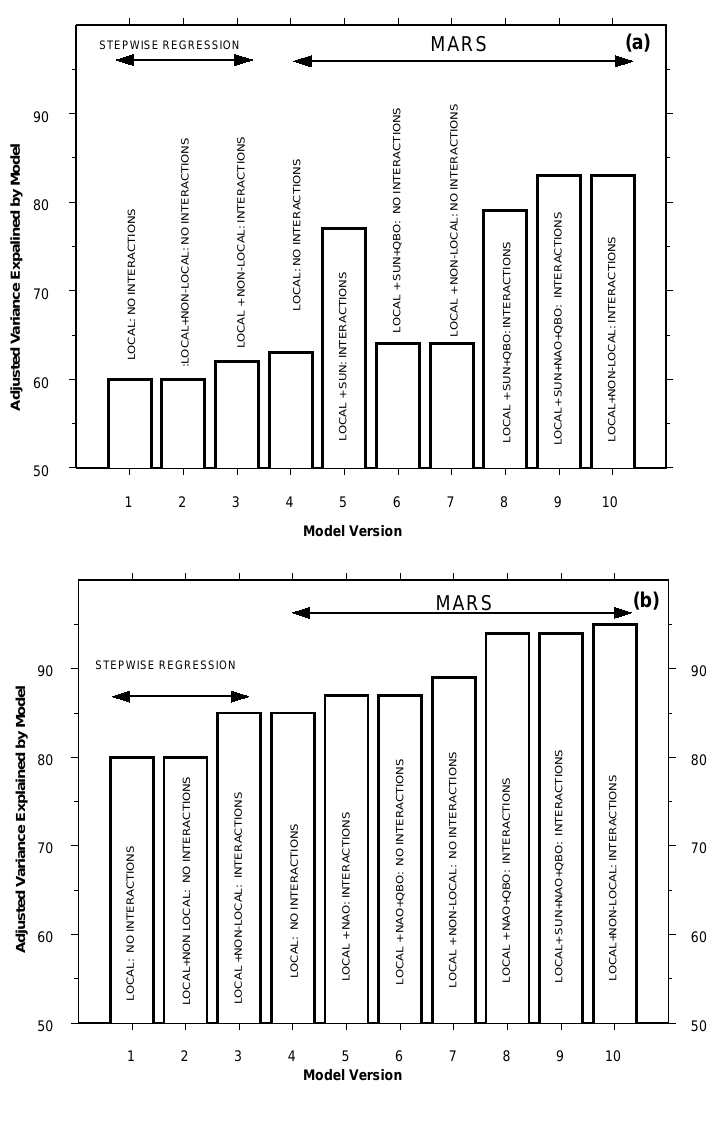
Fig. 2. The adjusted variance, Adj.R 2 , explained by various statistical models including (or omitting) interactions be- tween the UV regressors and taking into account selected non-local regressors, shown in Figs. 1a–e, for the stepwise re- gression and MARS model. Figures 2a and b show the results for the cloud cover regressors and total solar radiance used as proxies for the cloud effects on UV,